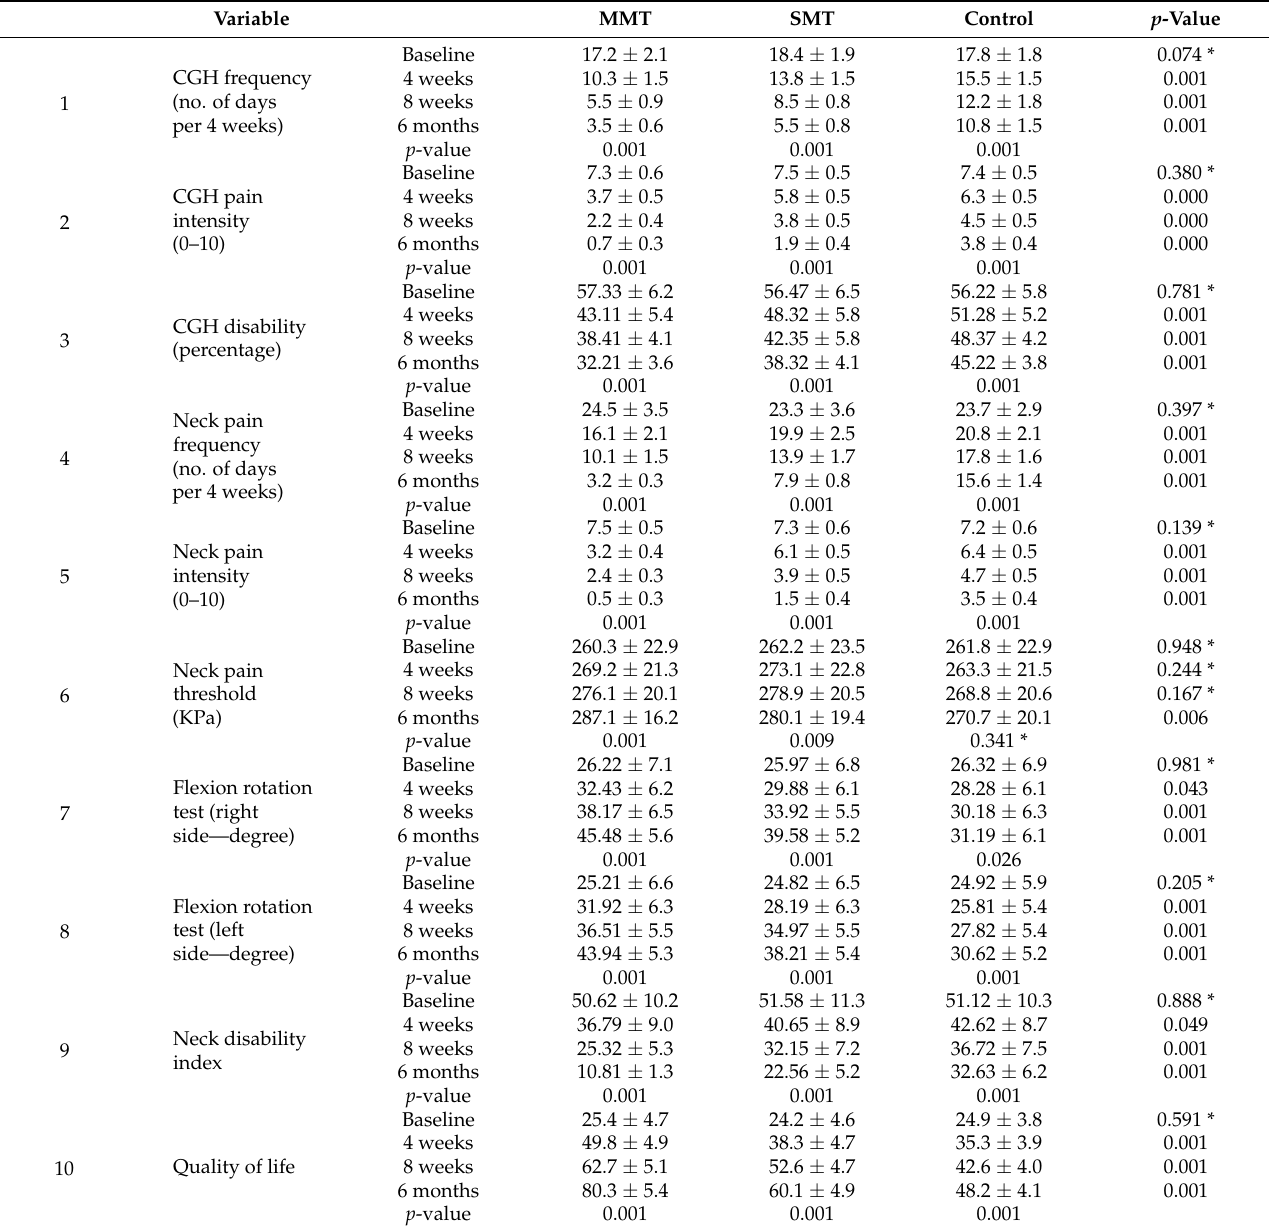
Table 2. Primary and secondary outcome variable analysis of MMT, SMT, and control